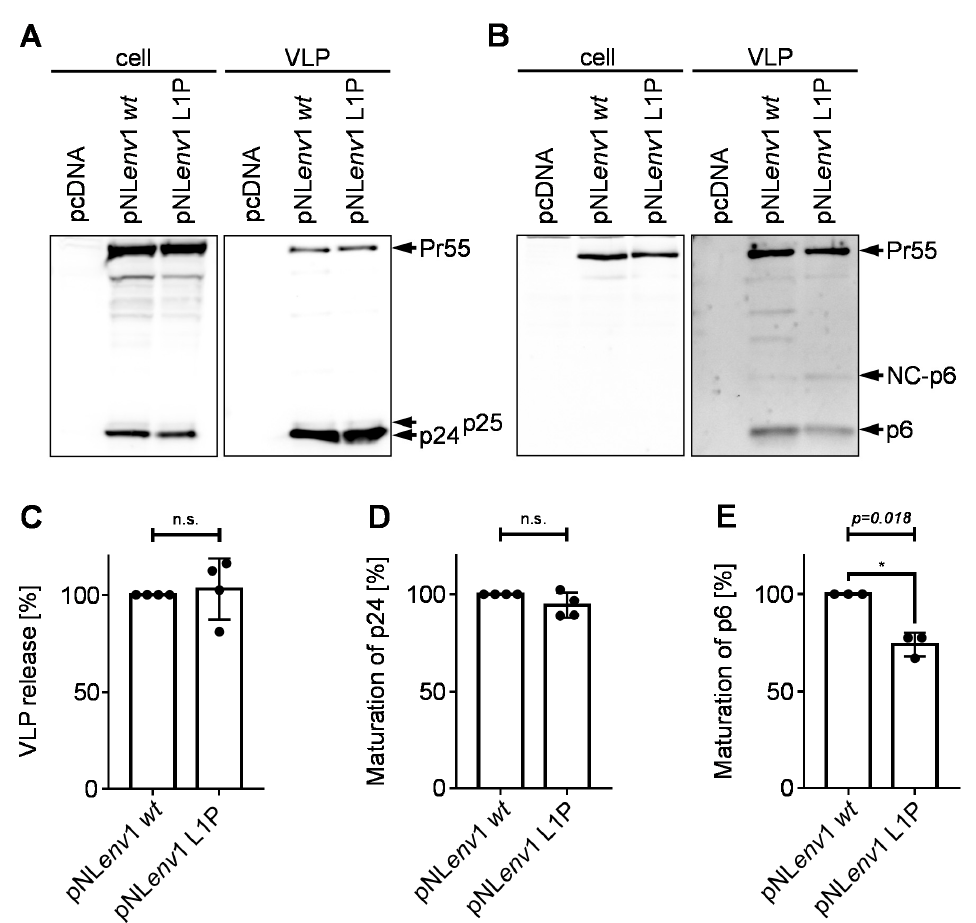
Figure 4. Influence of the mutation L1P on virus release and Gag-processing. HeLa SS6 cells were transfected with pNL env 1 wt or pNL env 1 L1P, respectively. Cell lysates and VLP fractions were